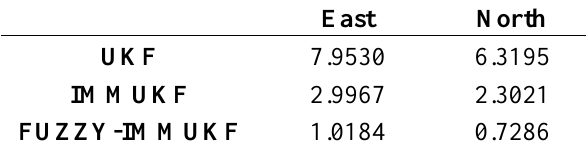
Table 2. Position accuracies for the three approaches (RMS errors, in